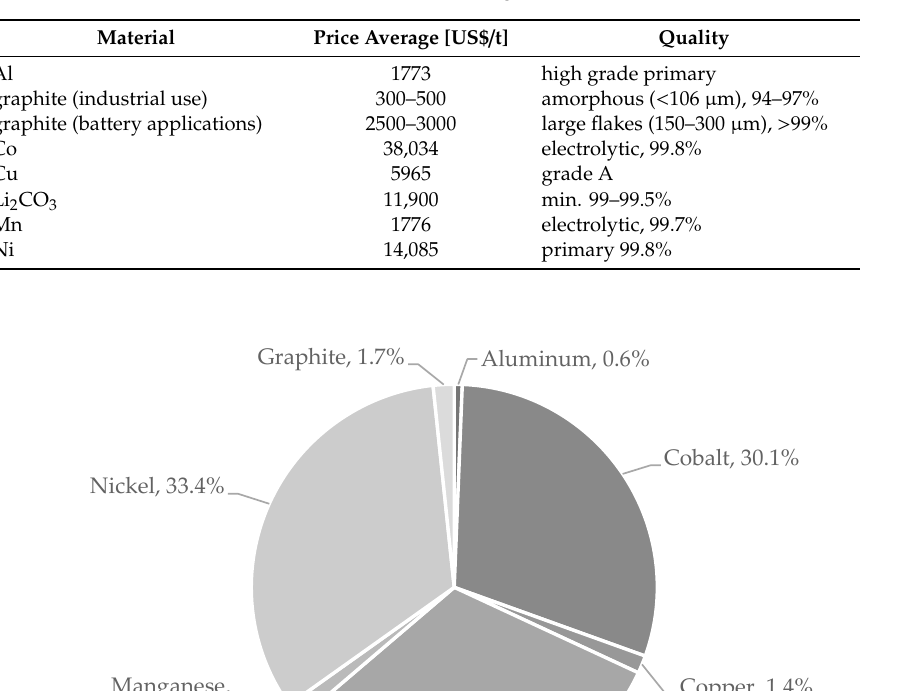
Table 7. Prices of materials based on an average 03 / 2019–02 / 2020 [103,104].